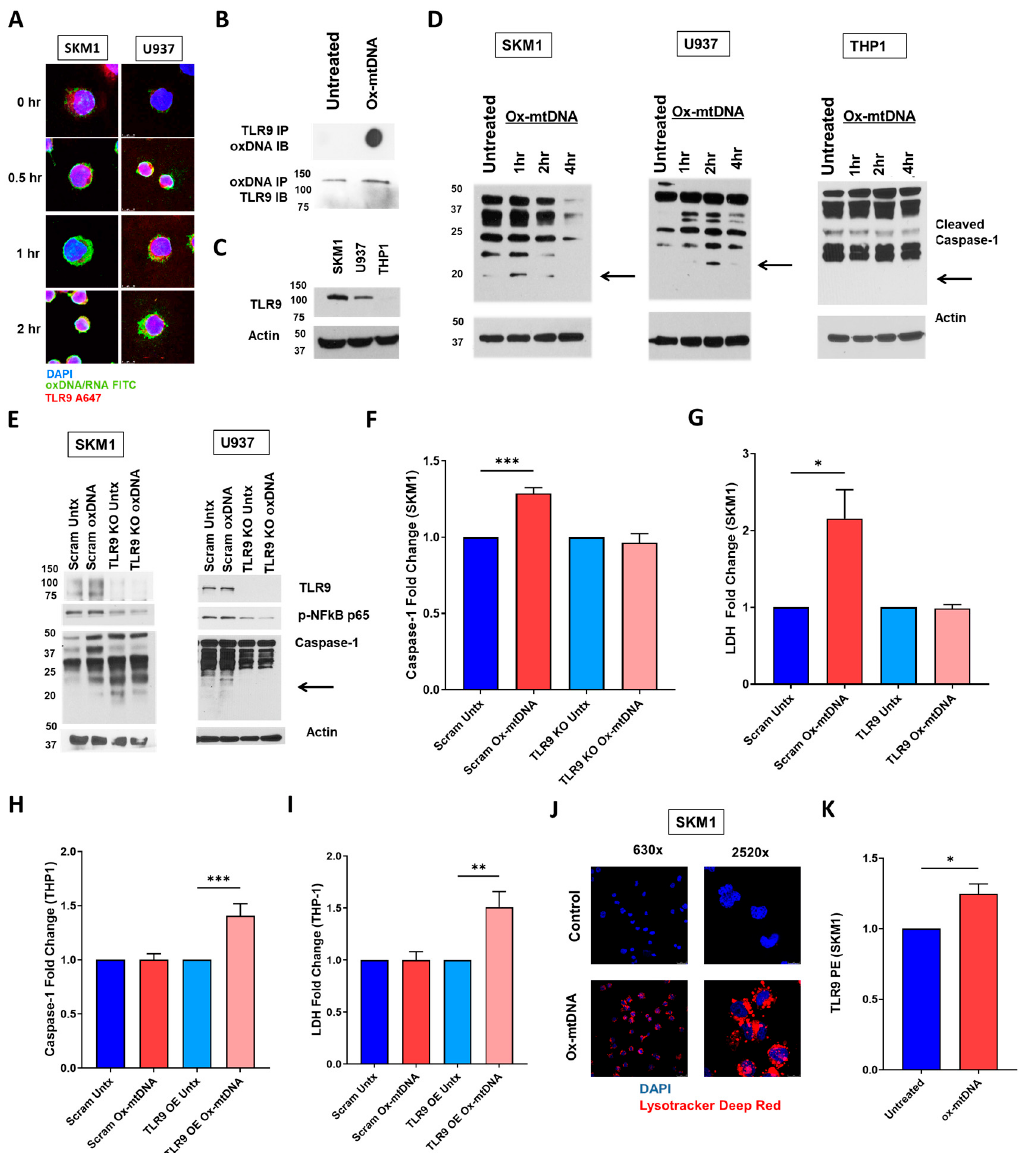
Figure 3. Ox-mtDNA triggers internalization via TLR9 activation. ( A ) Time-dependent co-localization of ox-mtDNA with TLR9 and receptor:ligand internalization demonstrated by confocal IF, in SKM1 and U937 cells [DAPI (blue), oxDNA (green), TLR9 (Red), representative micrographs of three independent experiments]. ( B ) Following ox-mtDNA treatment, TLR9 immunoprecipitated to assess the binding of TLR9 to oxDNA by dotblot and immunoblot (representative of n = 3). ( C ) Comparative TLR9 protein expression in SKM1, U937, and THP1 by Western blot (representative of n = 3). ( D ) SKM1, U937, or THP1 cells treated with 50 ng/mL ox-mtDNA followed by caspase-1 Western blot. ( E ) Western blot of caspase-1 and NF κ B activation in SKM1 and U937 cells using CRISPR/Cas 9 gene editing to KO TLR9 expression. ( F ) Fold change of caspase-1 activity and ( G ) LDH media release in TLR9 KO SKM1 and U937 cells treated with ox-mtDNA (mean ± SEM of n = 3). ( H ) Fold change of caspase-1 activity and ( I ) LDH media release in TLR9 overexpression THP-1 cells treated with ox-mtDNA (mean ± SD of n = 3). In F through I, significance was assessed by ordinary one-way ANOVA with multiple comparison analysis. ( J ) Confocal IF of SKM1 cells treatment with 50 ng/mL ox-mtDNA for 2 h to assess induction of lysosomes [DAPI (blue), Lysotracker (Red)]. Representative micrographs, three independent experiments. ( K ) Change in surface expression of TLR9 in response to ox-mtDNA treatment by flow cytometry. Significance analyzed by Student t -test (MFI ± SD, n = 3) . p values are shown as asterisk: * p ≤ 0.05, ** p ≤ 0.01, *** p ≤ 0.001